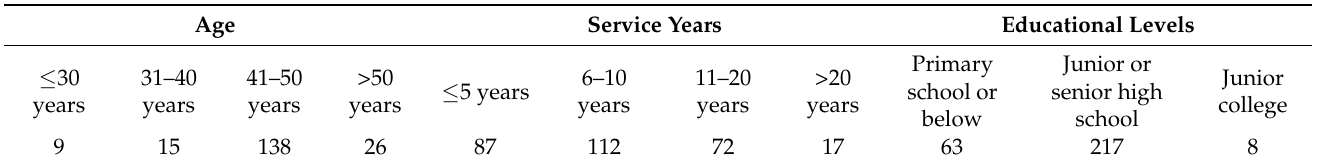
Table 4. The basic information of the surveyed